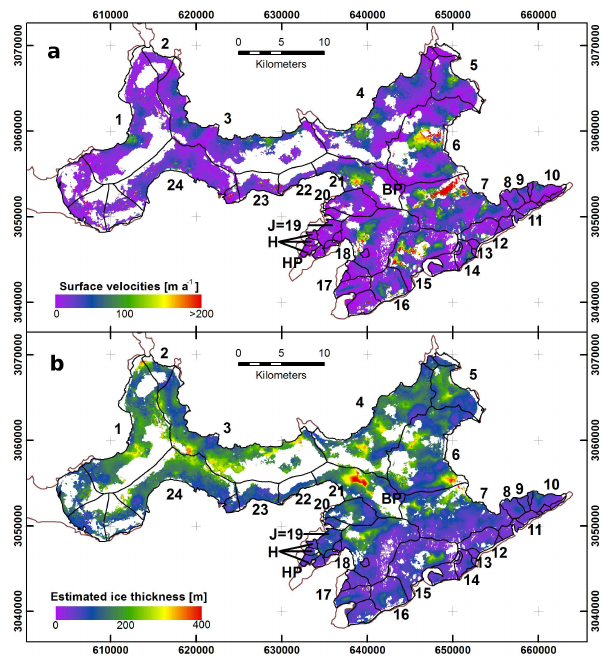
Figure 6. (a) Surface velocities obtained from SAR feature track- ing. Huron Glacier (7) shows the fastest flow. (b) Estimated ice thickness computed from surface velocity using Eq. (5). The brown lines indicate the extent of the ice-free